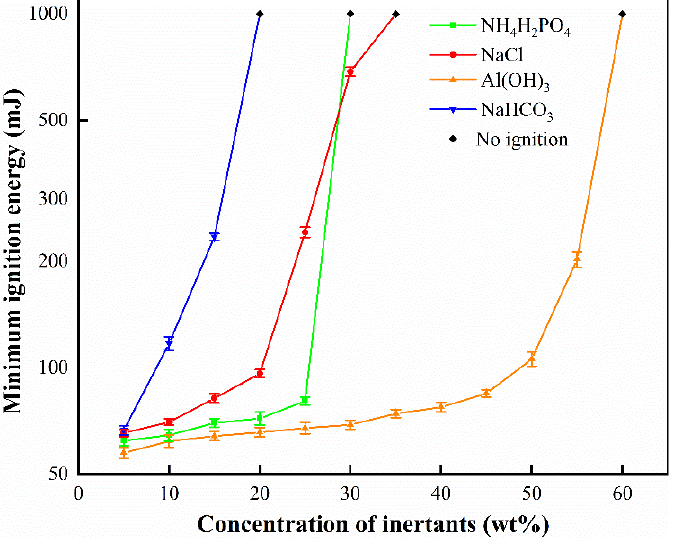
Figure 2. Effect of four inert powders in different mass concentration on sucrose dust.